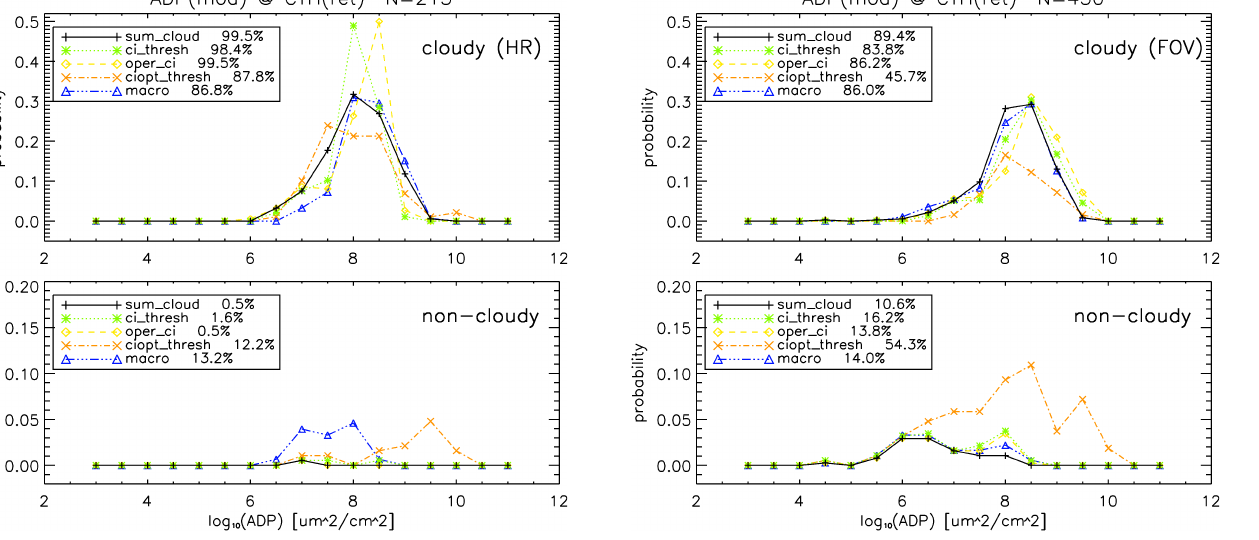
Fig. 9. Probability density functions (PDF) of all “true state” ADP values from the BTR input data (Scenarios 1–3) at the retrieved CTH of the various detection methods (top) in comparison with the PDF of the maximum “true state” ADP in the profiles where the detection methods retrieved non-cloudy conditions (bottom). Both analyses were carried out for the high-resolution (HR) model fields. Total percentages of detected and non-detected clouds for each method are presented in the figure legends.